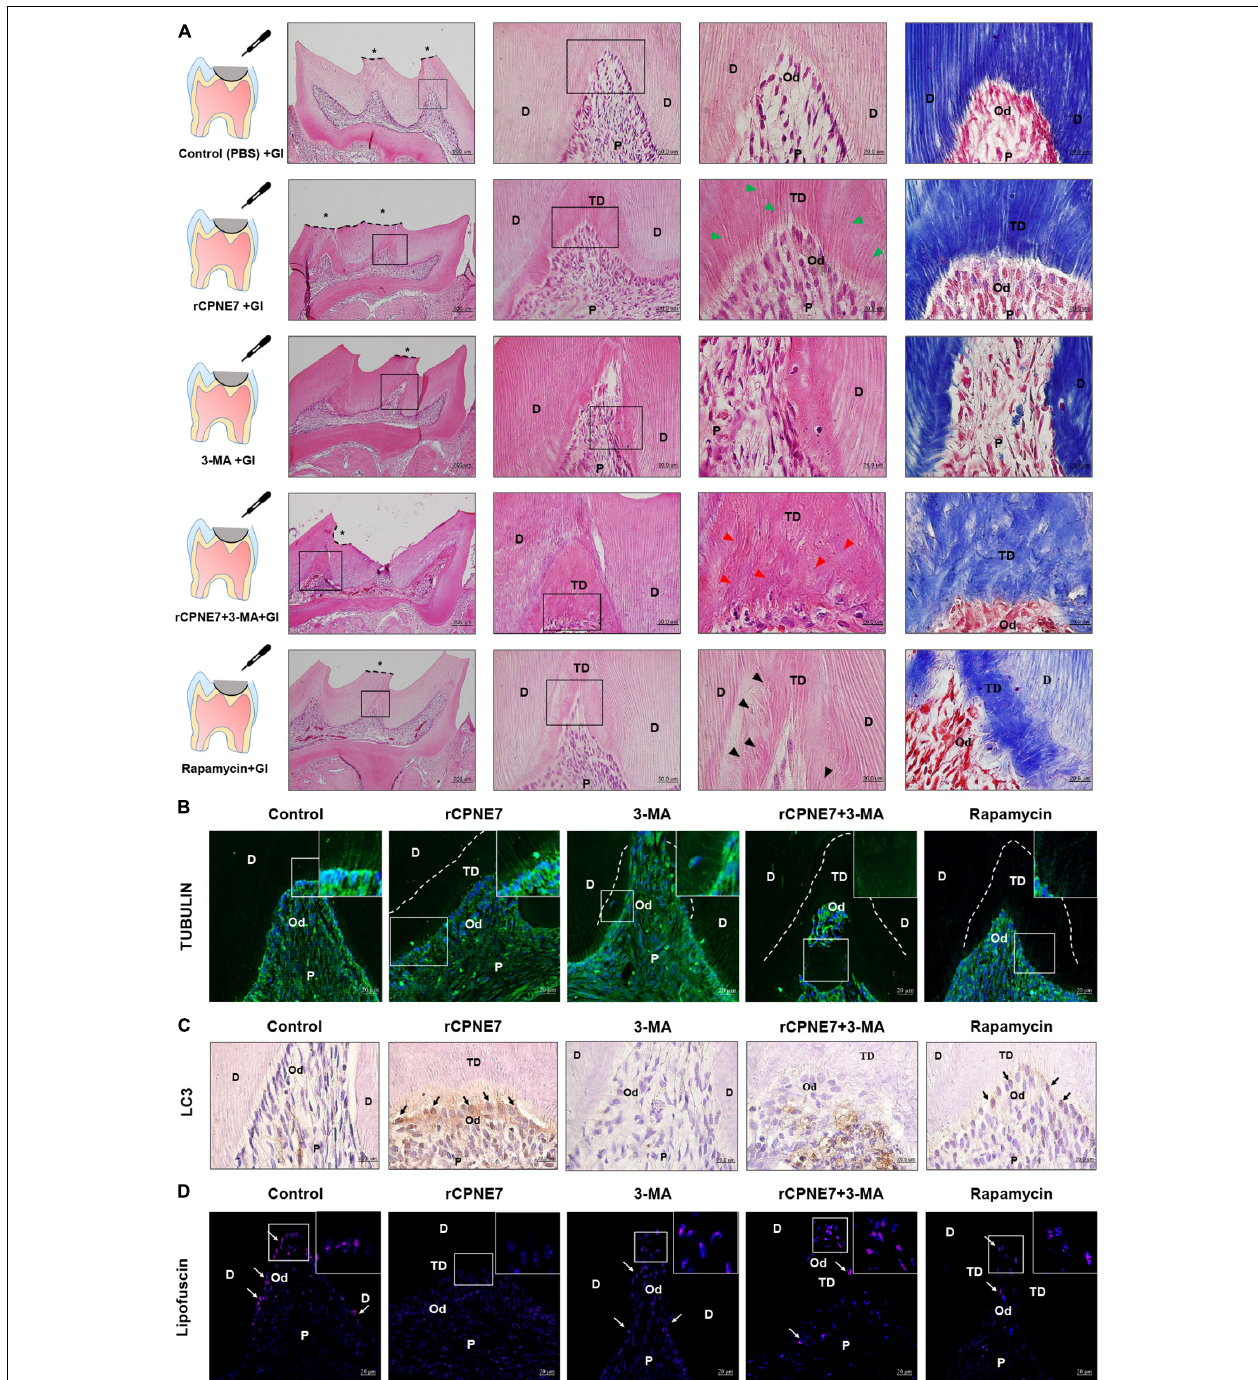
FIGURE 5 | CPNE7 promotes the formation of dentin in vivo . (A) Schematic diagrams of the mouse molar defect model. The defect areas were covered with glass ionomer (GI) cement after topical treatment: control (PBS + GI), rCPNE7 (rCPNE7 + GI), 3-MA (3-MA + GI), rCPNE7 and 3-MA (rCPNE7 + 3-MA + GI), or rapamycin (rapamycin + GI). Histologic analysis of the defect areas were performed 4 weeks later using H&E and Masson’s trichrome staining. Scale bars = 200 µ m. Boxed areas are shown at higher magnification. Scale bars = 50 µ m and 20 µ m. Odontoblast process-like structures (green arrowheads) were observed in the rCPNE7 + GI group. Few odontoblast process-like structures (red arrowheads) were observed in the rCPNE7 + 3-MA + GI group. Irregular and entangled cellular processes (arrowheads) were observed in the rapamycin + GI group. (B) Representative immunofluorescence images of tubulin (green). Dotted line shows the boundary of tubular dentin newly formed from native dentin. (C) LC3 expression (black arrow) was detected by immunohistochemistry. (D) Lipofuscin pigments (white arrows) were observed in odontoblasts at 488 nm. Scale bars = 20 µ m. Boxed areas are shown at higher magnification. P, pulp; Od, odontoblast; D, dentin; TD, tubular